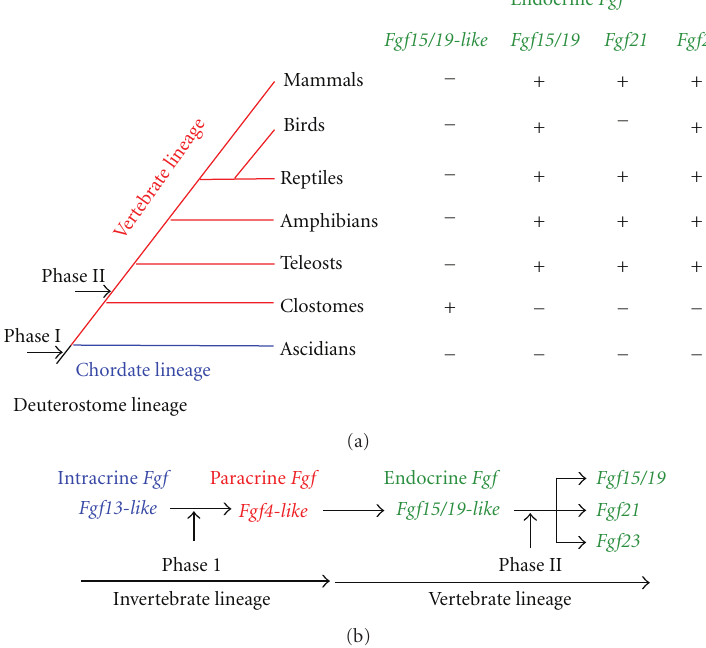
Figure 1: The evolutionary lineage of deuterostome organisms and the evolutionary history of endocrine Fgf genes. (a) The Fgf gene family expanded in two major phases (I and II) during deuterostome evolution. Phase I occurred after the separation of protostomes and deuterostomes. Phase II occurred early in the emergence of vertebrates. (b) Fgf13-like is the ancestral gene of the Fgf gene family. Fgf4-like was generated from Fgf13-like by gene duplication during invertebrate evolution. Fgf15/19-like was also generated from Fgf4-like by local gene duplication early in the emergence of vertebrates. Later, Fgf19, Fgf21, and Fgf23 were generated via two genome duplication events in phase